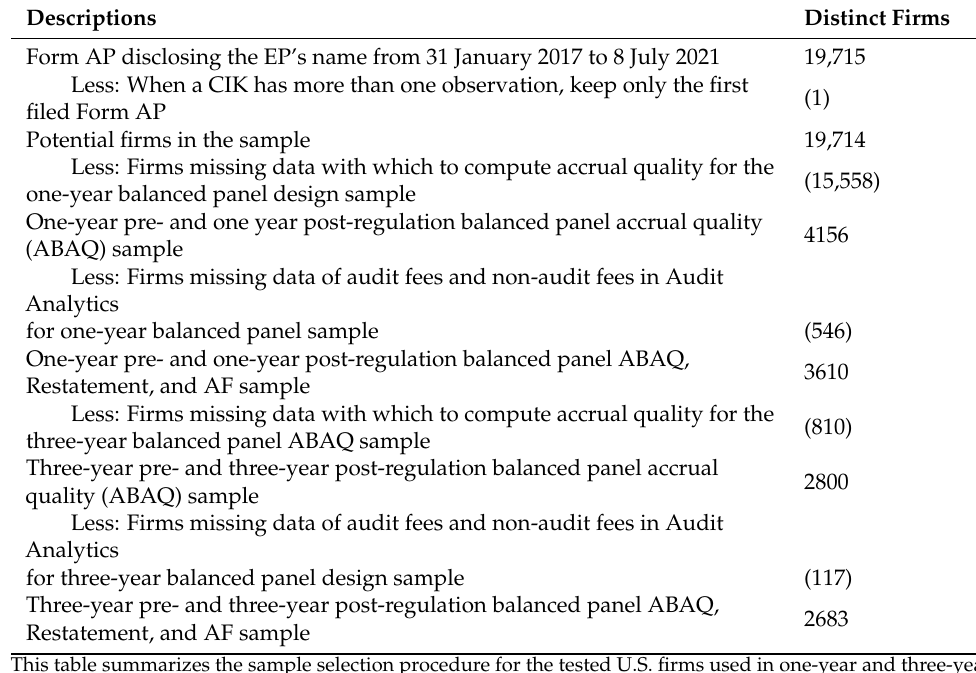
Table 1 summarizes the sample selection procedures. Table 1. Sample